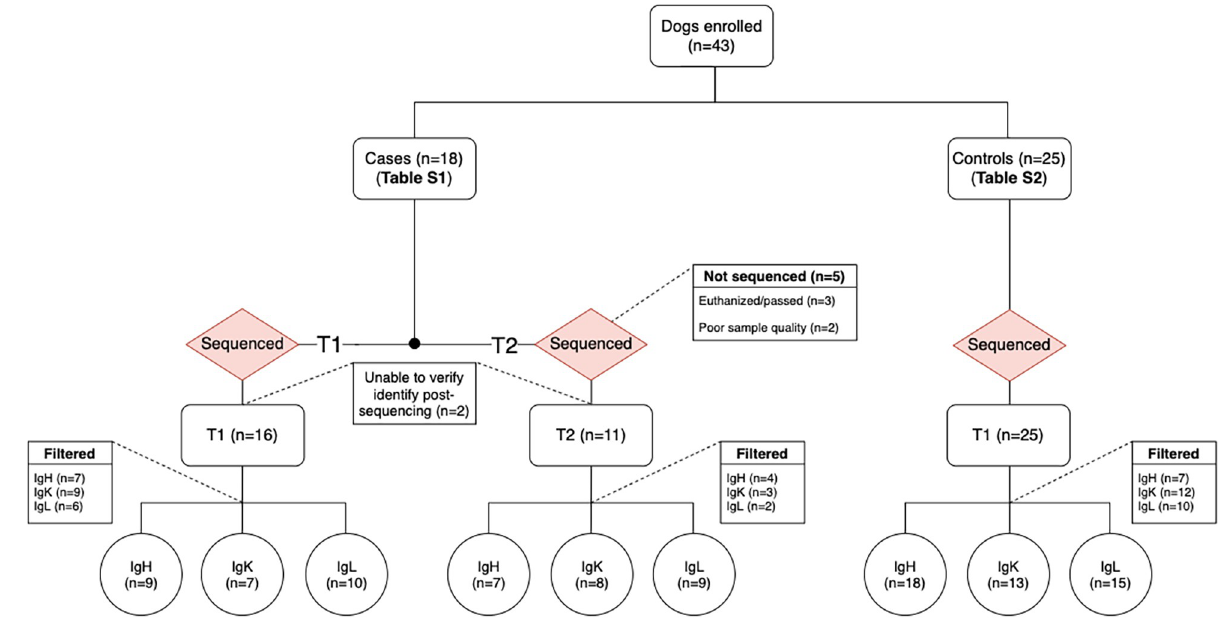
Fig 2. Sample flowchart. Cases and controls enrolled and analyzed across time points and chains (IGH, IGK, and IGL).